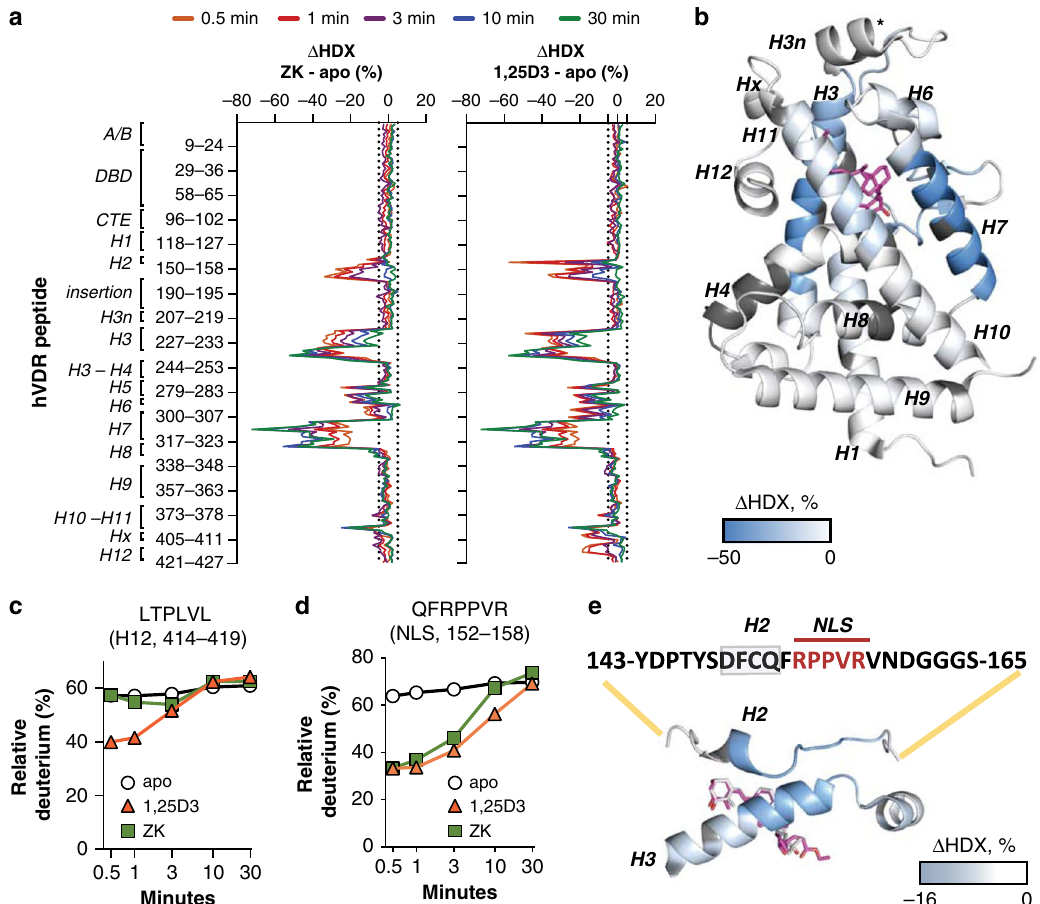
Fig. 2 Ligand-induced hVDR conformational changes. a Differential deuterium uptake ( Δ HDX) of hVDR between apo and ZK-bound (left panel) or 1,25D3-bound (right panel) hVDR/hRXR αΔ NTD heterodimers. The VDR LBD is composed of H1 – H12. Negative values indicate decreased deuterium incorporation upon ligand binding. Dashed lines represent a Δ HDX of 5%. b Average Δ HDX of hVDR between ZK-bound and apo-hVDR/hRXR αΔ NTD heterodimers across the various time points mapped onto hVDR LBD (PDB: 1DB1 44 ). Regions not covered by HDX-MS are shown in dark gray. Differential deuterium uptake plots of the hVDR residues 414-LTPLVL-419 located in H12 ( c ) and of 152-QFRPPVR-158 located in the H1 – H3 loop ( d ) determined in ZK- bound, 1,25D3-bound and apo hVDR/hRXR αΔ NTD heterodimers. e Zoom of average Δ HDX across the various time points of the VDR region encompassing H2 and a nuclear localization signal (NLS) mapped onto the hVDR LBD (PDB: 1DB1 44 ). HDX-MS data were collected in triplicates, and deuteration data were normalized to the maximal theoretical uptake